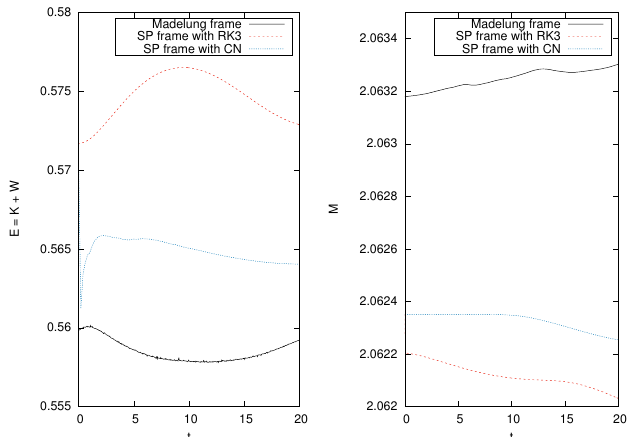
Figure 5. Evolution of the total energy E = K + W and the mass M as a function of time in the two frames for the boosted